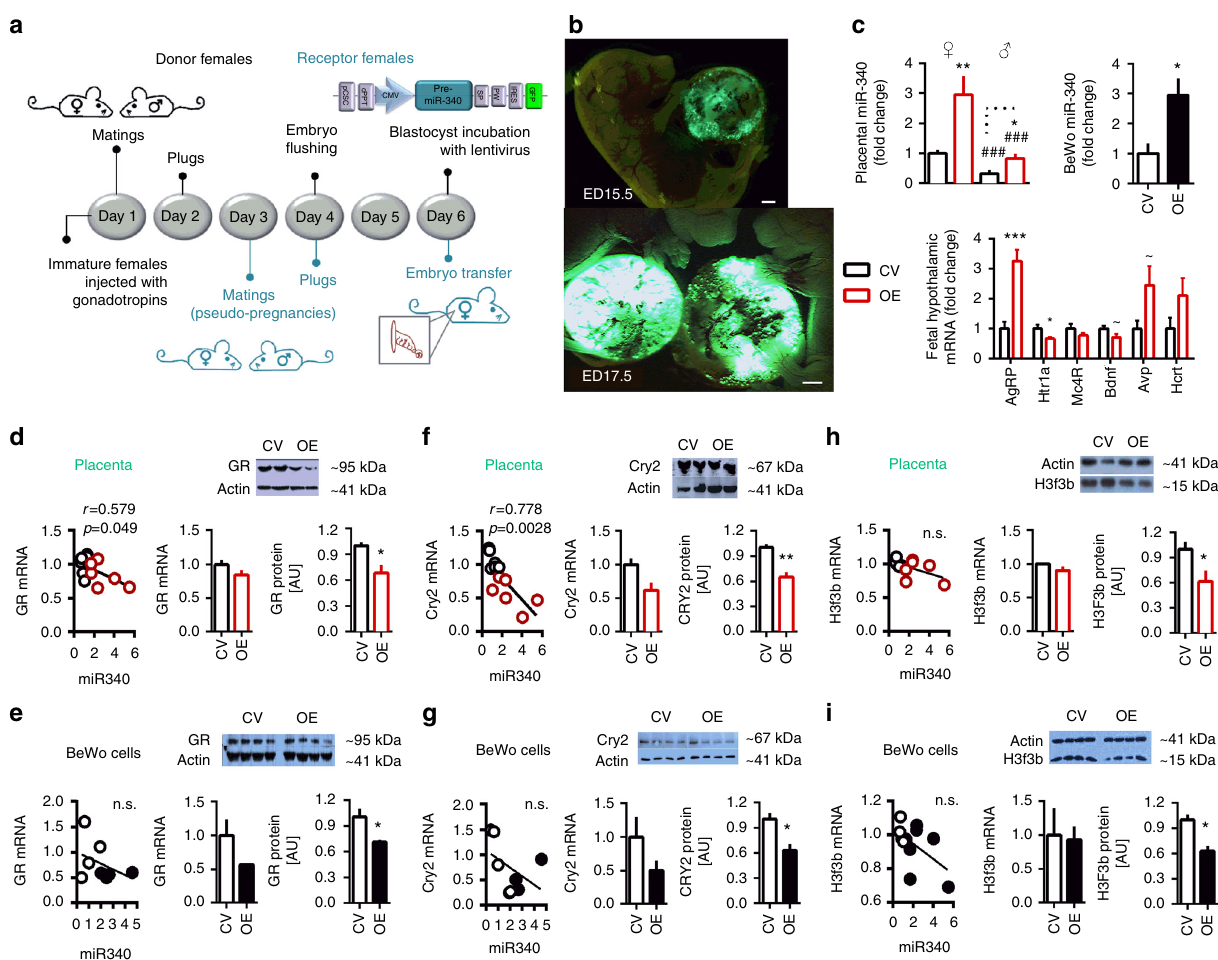
Fig. 5 MiR-340 overexpression (OE) decreases GR, CRY2, and H3F3b protein in the placenta and in BeWo cells. a Experimental design for generation of placenta-speci fi c transgenes. b Representative pictures out of about 20 transfers of placenta-speci fi c infection. c Placental miR-340 was highly expressed in the female transgenes of both groups compared to males (two-way ANOVA F sex(1,23) = 47.39, p < 0.0001) and was increased by the miR-340 OE lentivirus in both sexes ( F treatment(1,23) = 28.78, p < 0.0001, N = 6). Infection of BeWo cells with the miR-340 OE lentivirus led to increase in miR-340 expression levels (Unpaired t test t (6) = 1.77, p = 0.019). Fetal hypothalamic gene expression of anorexia candidate genes differed between the CV and miR-340 OE groups (MANOVA F (6,5) = 7.08, p = 0.024), with high expression of AgRP and low expression of Htr1a . d In miR-340 OE transgenes, placental GR mRNA inversely correlated with miR-340 ( N = 6) and placental protein tended to be reduced ( t (6) = 2.414, p = 0.052, N = 4). e In BeWo cells, Nr3c1/ GR mRNA x miR-340 correlation showed a similar pattern to the placenta and miR-340 OE decreased GR protein levels ( t (6) = 3.09, p = 0.011, N = 4). f Placental Cry2 mRNA inversely correlated with miR-340 ( N = 12) and showed decreased protein levels after miR-340 OE (Unpaired t test t (6) = 2.451, p = 0.049, N = 4). g In BeWo cells, miR-340 OE signi fi cantly decreased CRY2 protein levels ( t (6) = 3.381, p = 0.0148). h – i MiR-340 OE did not affect H3f3b mRNA expression but decreased H3F3b protein levels in the placenta ( t (6) = 2.452, p = 0.0451, N = 4) ( h ) and in BeWo cells ( t (6) = 4.25, p = 0.0054, N = 4) ( i ). Data presented as mean and s.e.m. CV control virus. Scale bar: 1